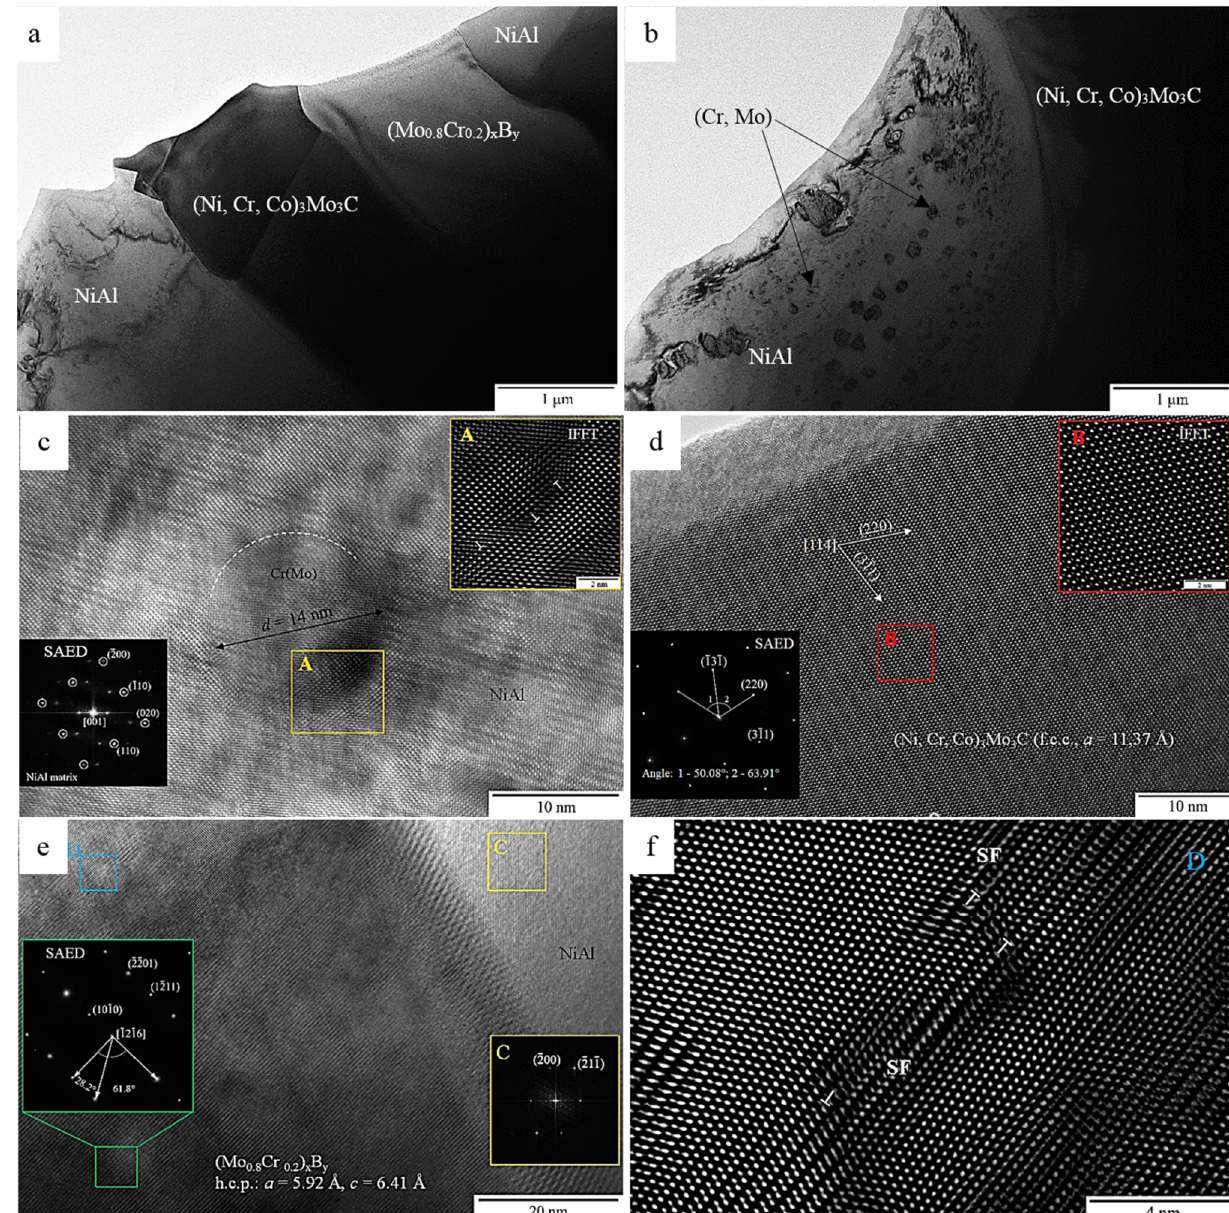
Figure 17. ( a , b ) The bright-field transmission electron microscopy (BF TEM) structure of the interface between the β -NiAl and Mo-containing phases. ( c ) The high-resolution TEM (HRTEM) image of the fine structure of β -NiAl dendritic cell with a Selected Area Electron Diffraction (SAED) inset taken along the [001] zone axis. The Inverse Fast Fourier Transformation (IFFT) filtered image of the area marked with A is shown in the upper right inset. ( d ) The HRTEM structure of the (Ni,Co,Cr) 3 Mo 3 C grain with a SAED inset taken along the [1 ̅ 14] zone axis. The IFFT filtered area marked with B is shown in the upper right inset. ( e ) The fine structure of the NiAl/(Mo 0.8 Cr 0.2 ) x B y interface with a SAED inset taken along the [1 ̅ 21 ̅ 6] zone axis. The Fast Fourier Transformation (FFT) filtered image of the area marked with C is shown in the lower right inset. ( f ) The IFFT filtered image of the fault crystal structure from the area is marked with D in Figure 17e.